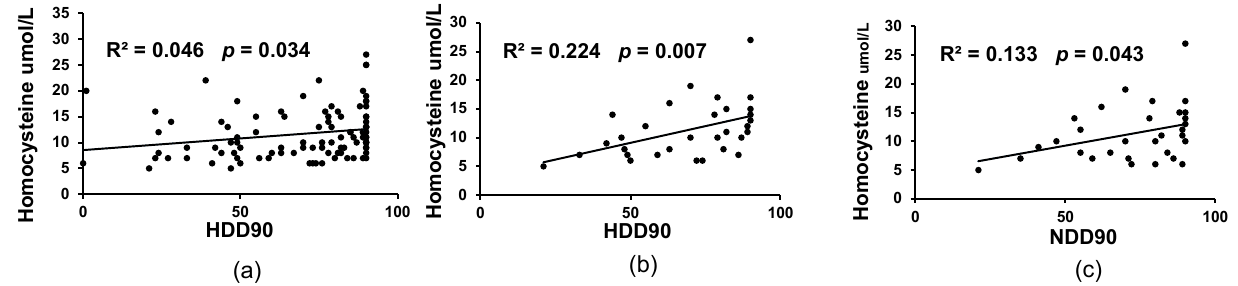
Figure 1. Relationship between serum homocysteine level (SHL) and drinking markers. ( a ) Significant positive association between SHL and heavy drinking days past 90 days (HDD90). ( b ) Significant positive association between SHL and HDD90 in all AUD females. ( c ) Significant positive association between SHL and number of drinking days past 90 days (NDD90) in all AUD females. Statistical significance was set at p ≤ 0.05. R 2 denotes the effect of the relationship as an outcome of univariate linear regression.